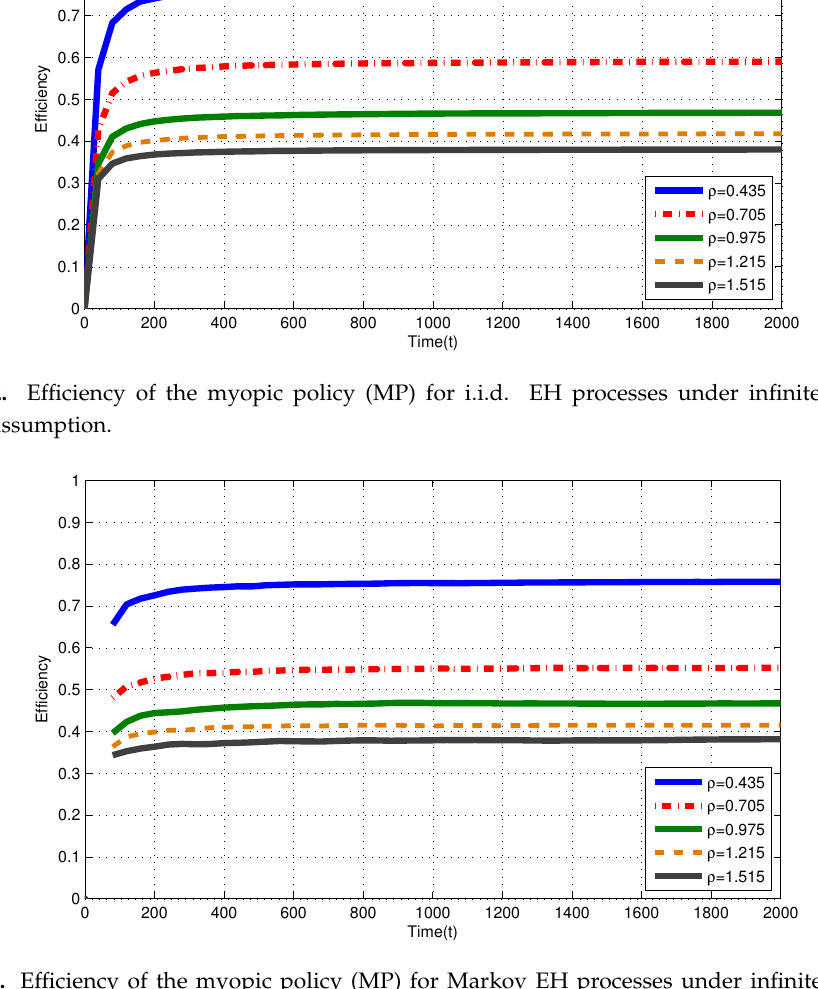
Figure 3. Efficiency of the myopic policy (MP) for Markov EH processes under infinite capacity battery